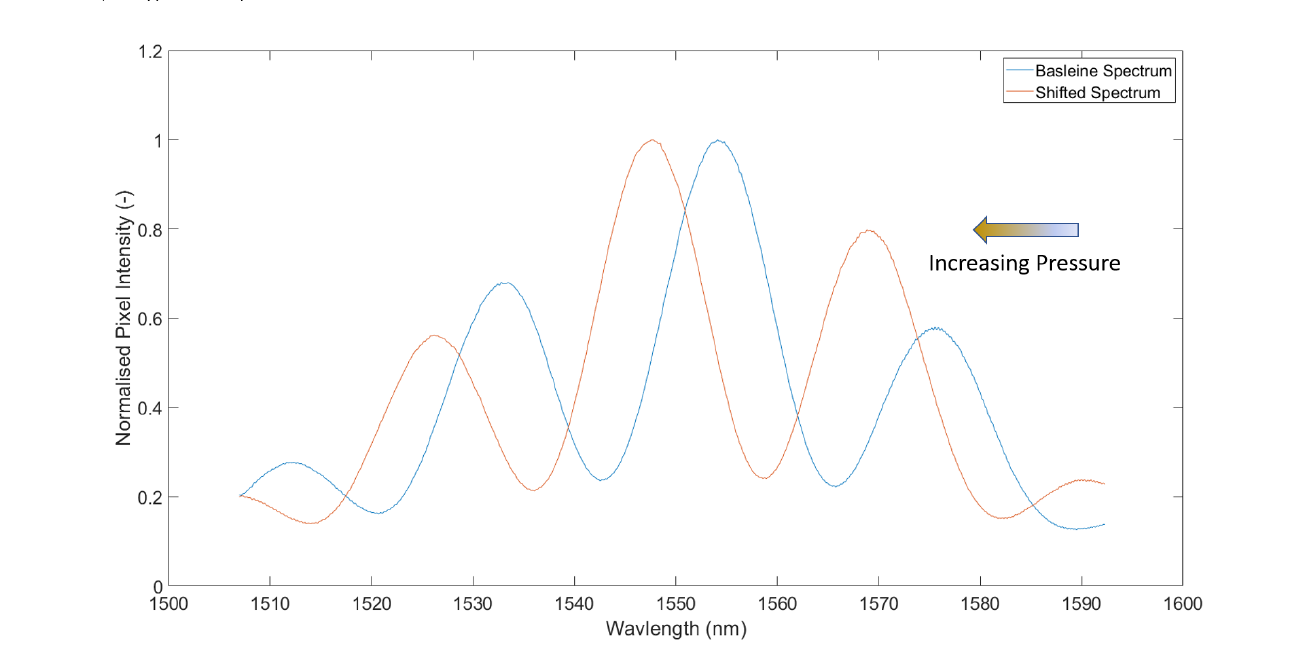
Figure 10. Sample EFPI interference pattern where peaks (signified by arrows) are approximately 30 nm apart, indicating a cavity length of 41 µm.